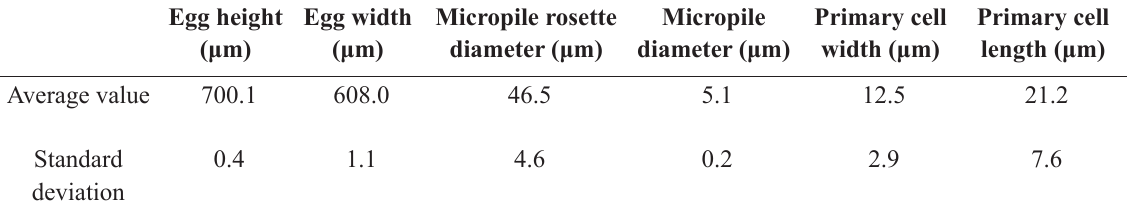
Table 4. Measurements of the egg of M. shahvarica sp. nov.